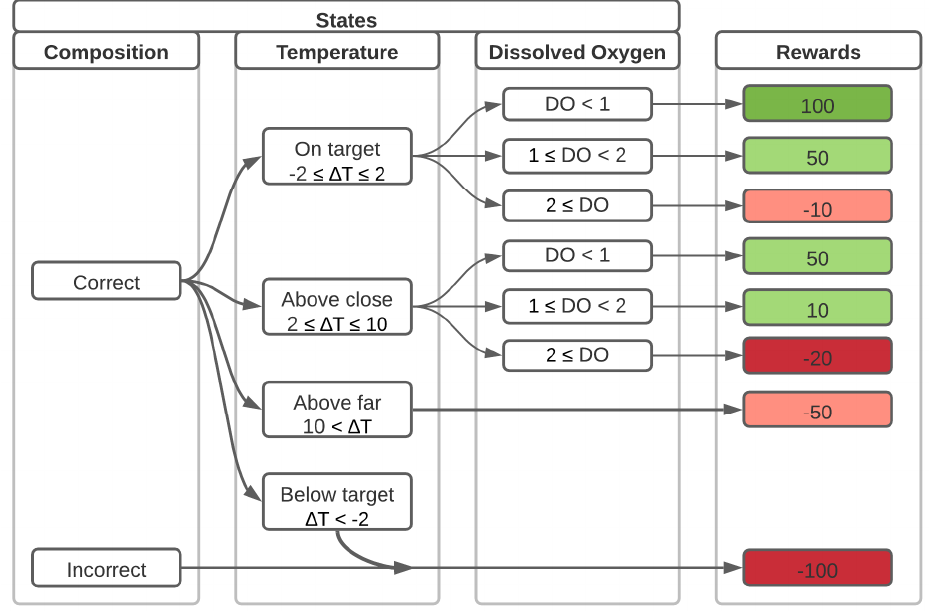
Figure 9. Rewards for the final states with the correct composition.